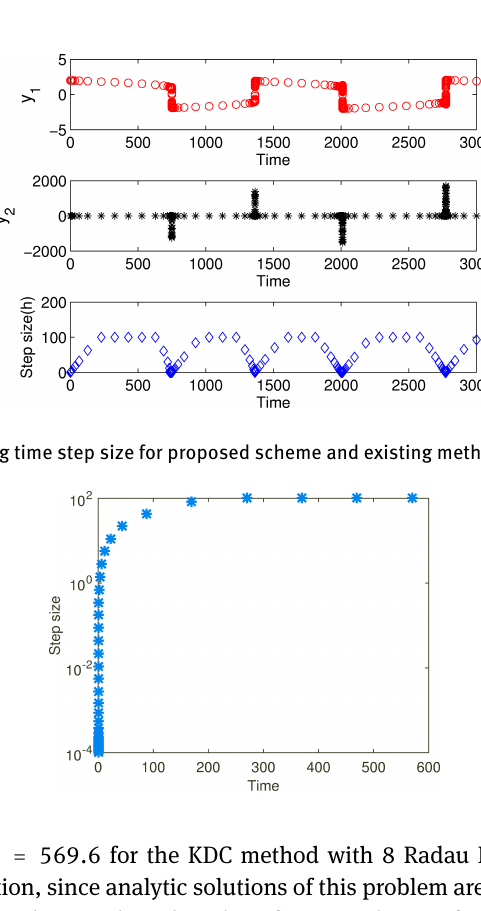
Fig. 3. Approximated solution ( y 1 ) behavior (above), approximated solution ( y 2 ) behavior (middle) and corresponding time step